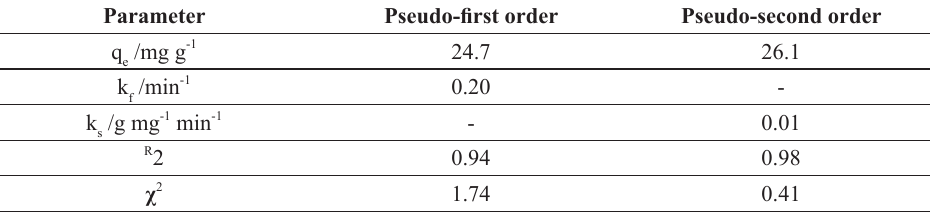
Parameter obtained by non-linear fi t of the kinetic models.